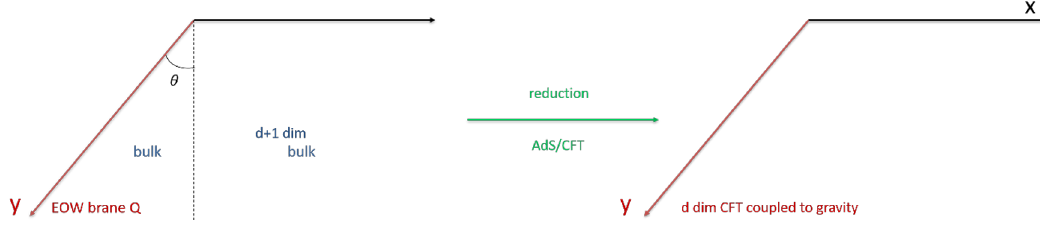
Figure 5 . Effective description with Neumann boundary